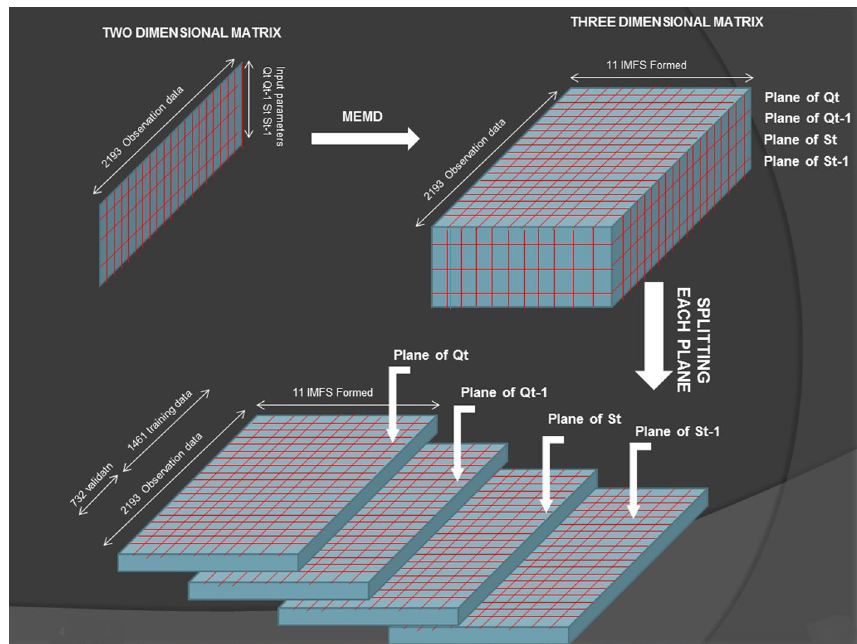
Fig. 1 Concept of multivariate dataset in MEMD, compris- ing of four inputs ( Q t , S t , S t −1 and Q t −1 ). Here Q t and S t are discharge and stage of current time step, respectively; Q t −1 and S t −1 are lag-1 discharge and stage